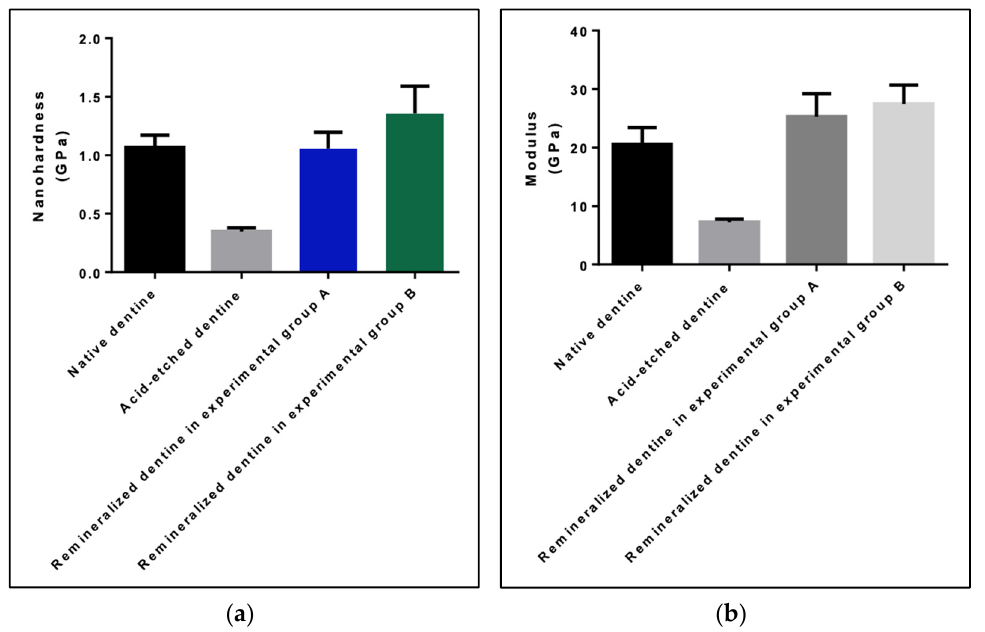
Figure 6. ( a ) Nanohardness and ( b ) modulus of native dentin slices, acid-etched dentin slices, remineralized dentin slices in experimental group A—without addition of GO, and remineralized dentin slices in experimental group B—with addition of GO.